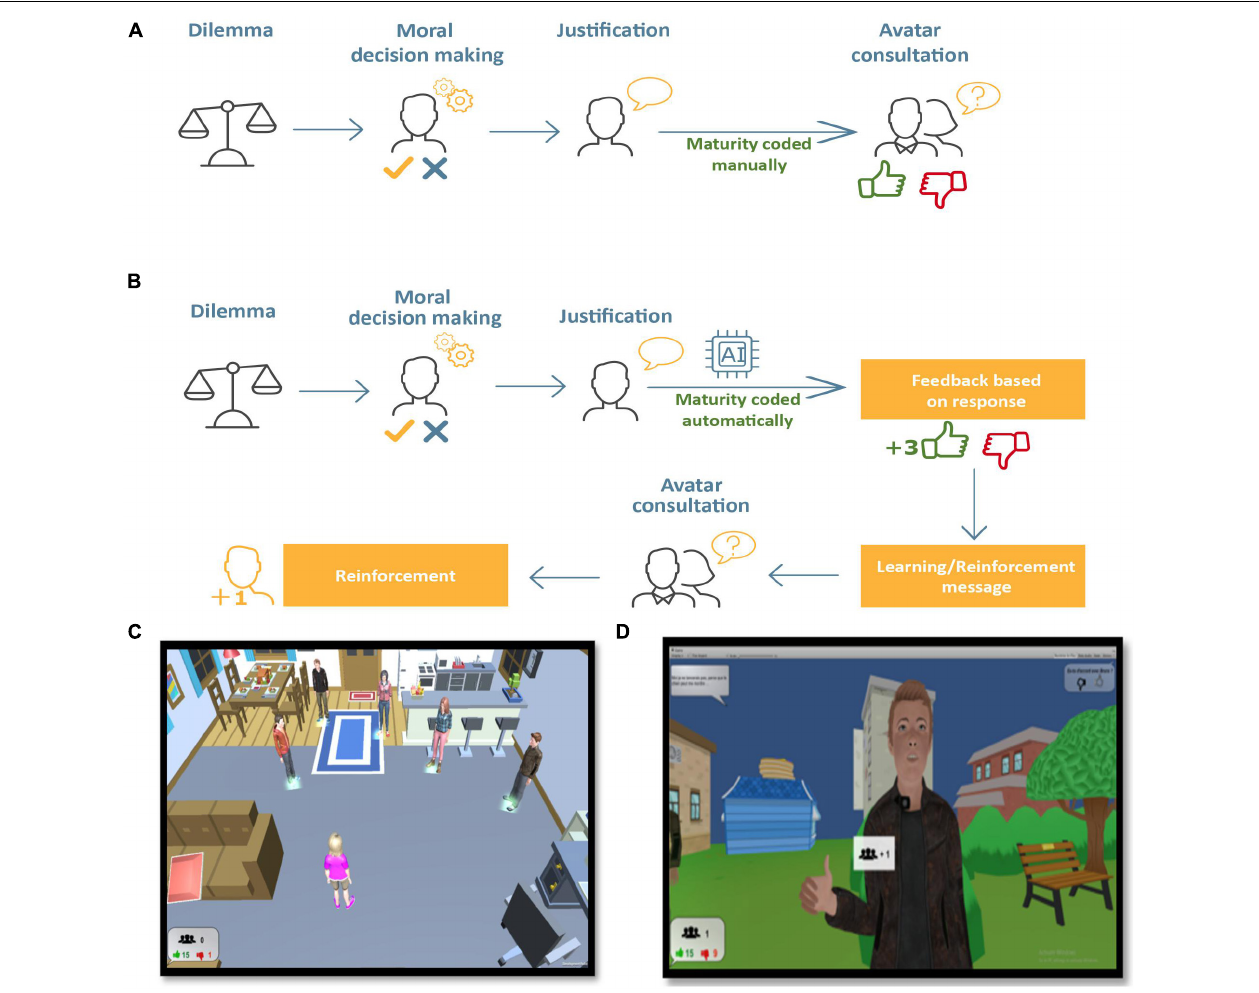
FIGURE 1 | Schematic representation of the sequence for one dilemma in the MorALERT game. (A) Evaluative version: the structure and coded are comparable to the original SoMoral task. Coding of justifications is performed manually. Players can consult with avatar friends to hear how they reason and indicate whether they agree (thumbs up) or disagree (thumbs down) with their reasoning, however, no feedback or reinforcement is provided. (B) Adaptive version: The overall structure of the dilemmas is comparable to the original SoMoral task; however, justifications are coded automatically in order to provide tailored feedback in the form of “likes” and audio learning/reinforcement messages based on moral maturity stage. After consulting with avatar friends to hear their reasoning about the dilemma, players and indicate whether they agree (thumbs up) or disagree (thumbs down) with their reasoning and obtain “friends” when they agree with a moral reasoning stage that is comparable or higher than their own. Screen captures from the MorALERT game. (C) The player, seen in the third-person perspective, faces five avatar friends. In both the evaluative and AVs, using the keyboard arrows, the player can consult each of the friends who will provide their own reasoning to the dilemma in the form of audio sound files. (D) In the AV, when the player agrees with friend justifications that are equal or higher maturity than their own response, they gain a “friend.” The left bottom screen shows the number of friends and number of likes and dislikes accumulated in the